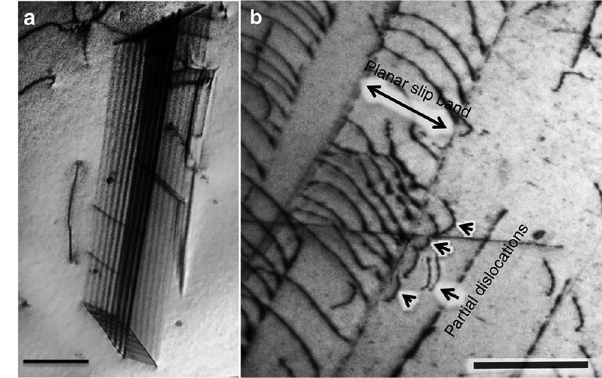
Figure 13: TEM of crack tip dislocation movement and stacking fault in the CrMnFeCoNi HEA, ( a ) the stacking fault parallelepiped, ( b ) dislocations with hindered movement [ 130 ]